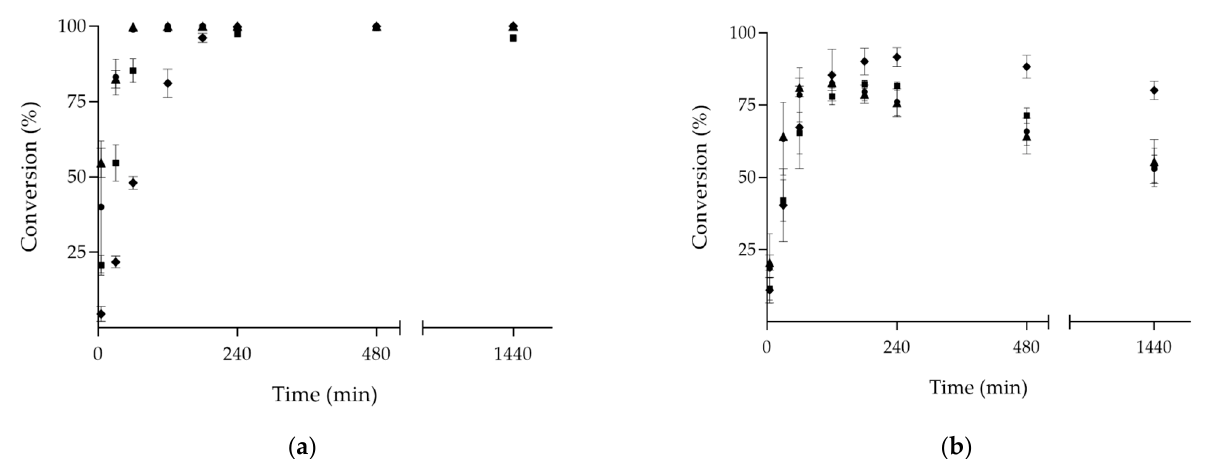
Figure 2. Enzymatic acylation of ( ± )-citronellol over time with ( a ) vinyl acetate and ( b ) ethyl acetate as acyl donors. Where: ( • ) PestE_wt; ( (cid:4) ) PestE_H95A; ( (cid:78) ) PestE_I208A; ( (cid:72) ) PestE_N288F. Reaction conditions: Molar ratio 1:10 (( ± )-citronellol:acyl donor), using 20 mM ( ± )-citronellol, 0.1% ( v/v ) Triton-X-100, 20 µ g · mL − 1 of the purified enzymes when ethyl acetate was used, or 0.2 µ g · mL − 1 of the purified enzymes when vinyl acetate was used, in 1 mL of an aqueous buffer (50 mM potassium phosphate, 300 mM sodium chloride, pH 8.0) at 1000 rpm and 40 ◦ C. Reactions were conducted in triplicate, and the average values are shown. Reactions without enzymes did not result in ester